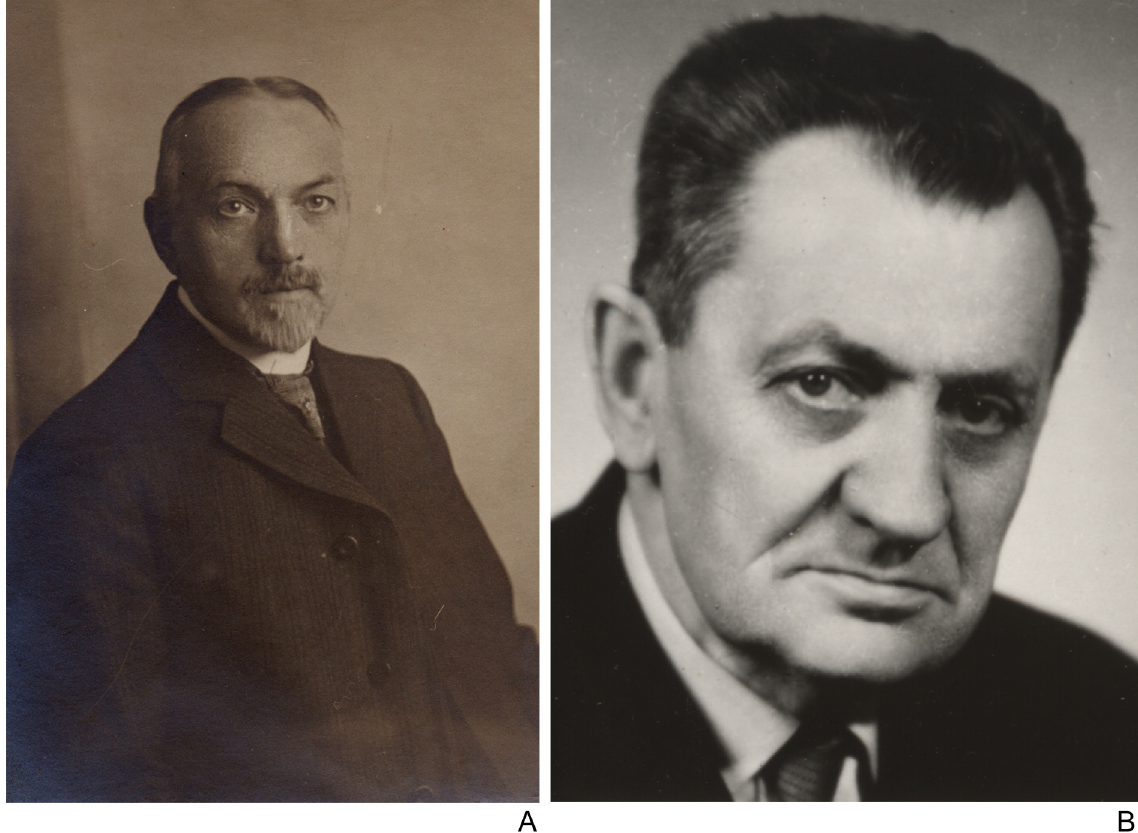
Fig. 3. The two great revisers of Canthon Hoffmannsegg, 1817 in the first half of the 20 th century. A . The German coleopterist Adolf Schmidt (1856–1923). After the publication of his two works on Scarabaeinae (Schmidt 1920, 1922), Canthon was composed of 143 valid species. Schmidt was the first author to recognize a group of species that, more than 50 years later, would constitute the core of the genus Sylvicanthon as proposed by Halffter & Martínez (1977). B . The Czech coleopterist Vladimír Balthasar (1897–1978), one of the first authors to recognize explicitly the great heterogeneity and artificiality of Canthon and to propose its division into several genera and subgenera. (Both images courtesy of Editha Schubert, from the archives of the Senckenberg Deutsches Entomologisches